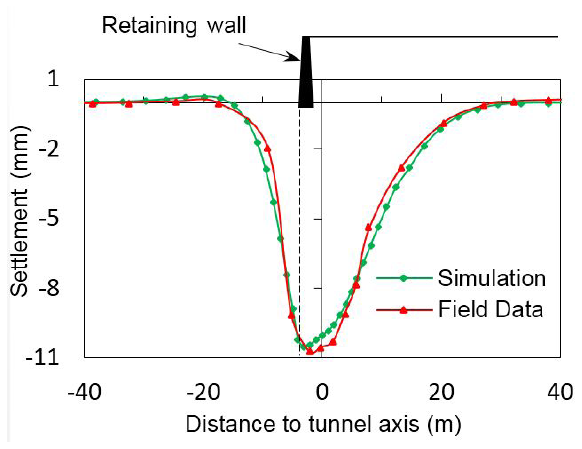
Figure 12: Final surface settlement troughs.